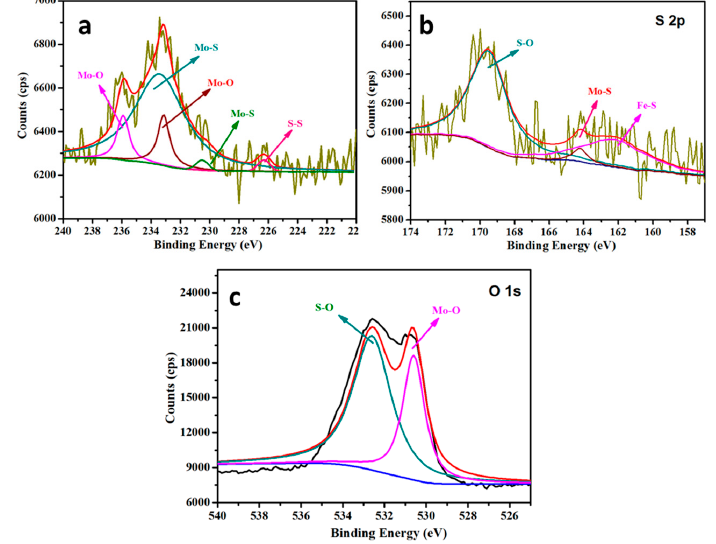
Figure 8. XPS results of wear scars on the steel discs lubricated by paroline oil with MoS 2 QDs: ( a ) Mo3 d ; ( b ) S2 p ; ( c ) O1 s . ( b ) S2 p ; ( c ) O1 s